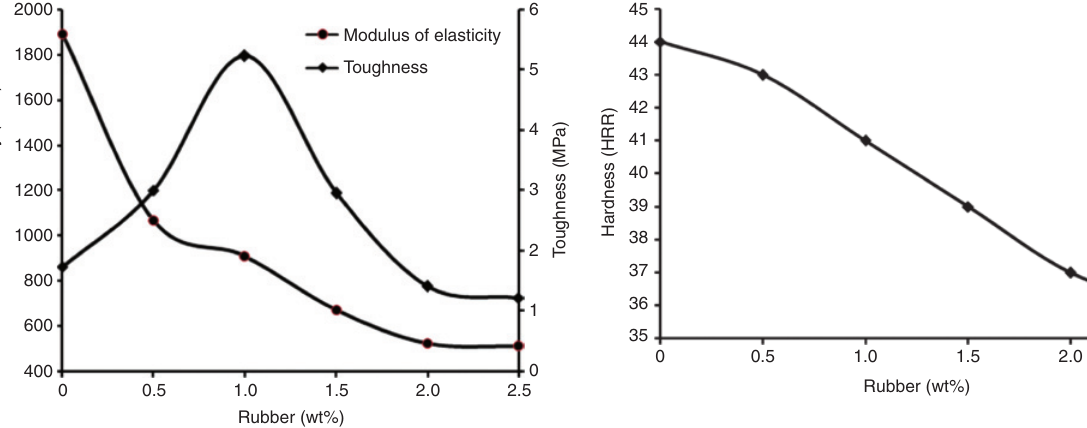
Figure 5 Modulus of elasticity and toughness of cured epoxy filled with different weight percentages of DNR.